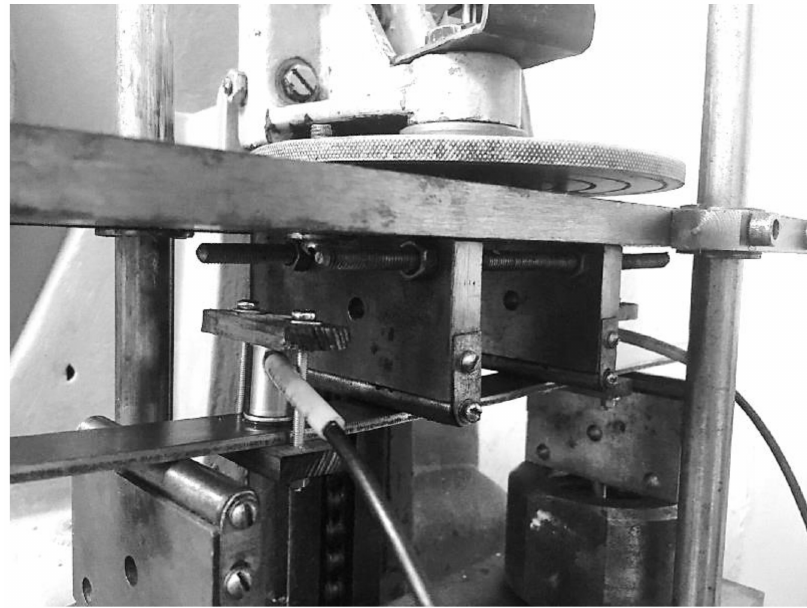
Figure 3. The acoustic emission device for studying bending deformation.